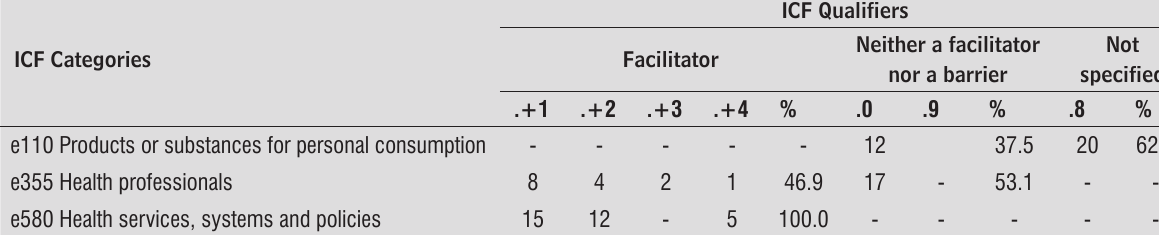
Table 3 - Frequency of older women with some facilitator for environmental factors (n = 32)